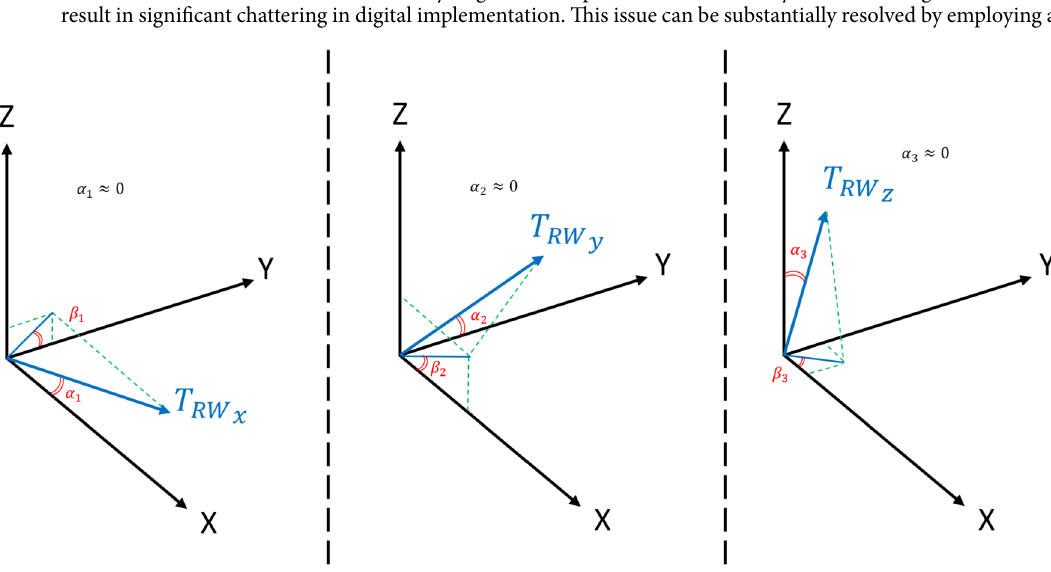
Figure 9. Reaction wheels’